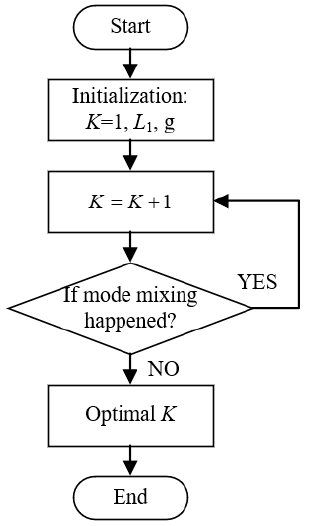
Figure 1. Flow chart of the proposed AVMD.